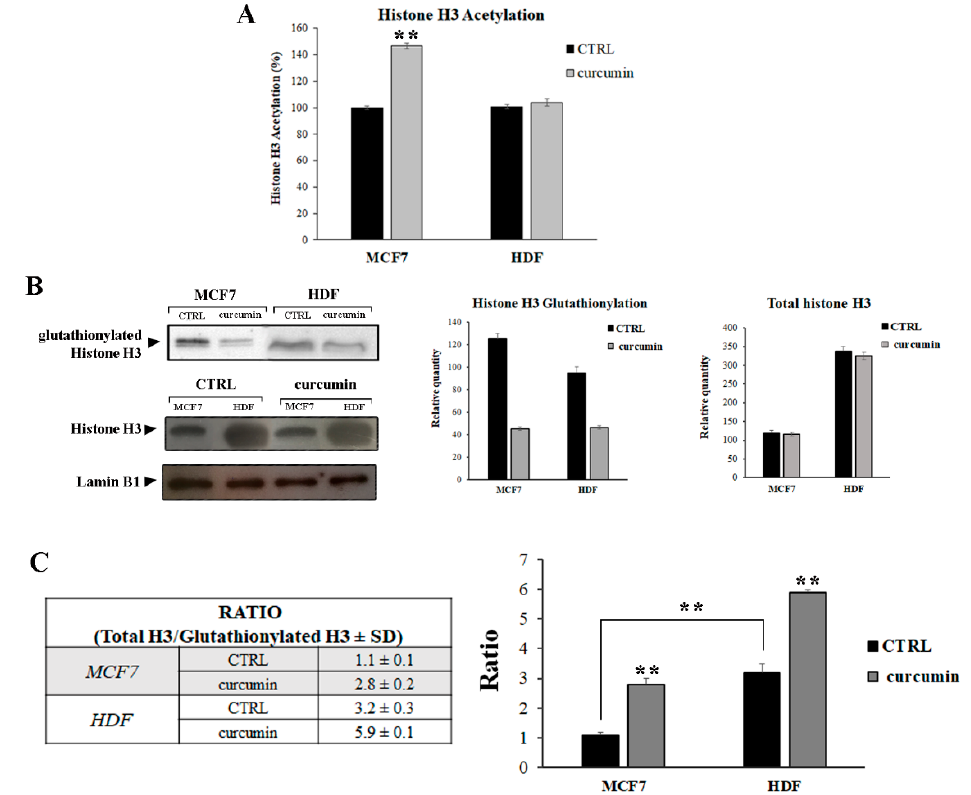
Figure 2. Post-translational modifications (PTMs) of the H3 histone induced by curcumin in MCF7 and HDF cells. ( A ) Histone acetylation evaluated using an acetylation assay kit (Abcam) and analyzed and quantified by ELISA. The percentage of acetylation was calculated as described in the Materials and Methods section. The control for both cell lines was set as 100% histone acetylation. ( B ) Histone S-glutathionylation and total H3 evaluated by Western blotting with anti-glutathione (GSH) and anti-H3 antibodies. The histograms represent the densitometric analysis ( n = 3). Lamin B1 has been used as a loading control. ( C ) Ratio of total H3 vs. glutathionylated H3. The histogram represents the values reported in the table, calculated by densitometric analysis. ** p < 0.001.